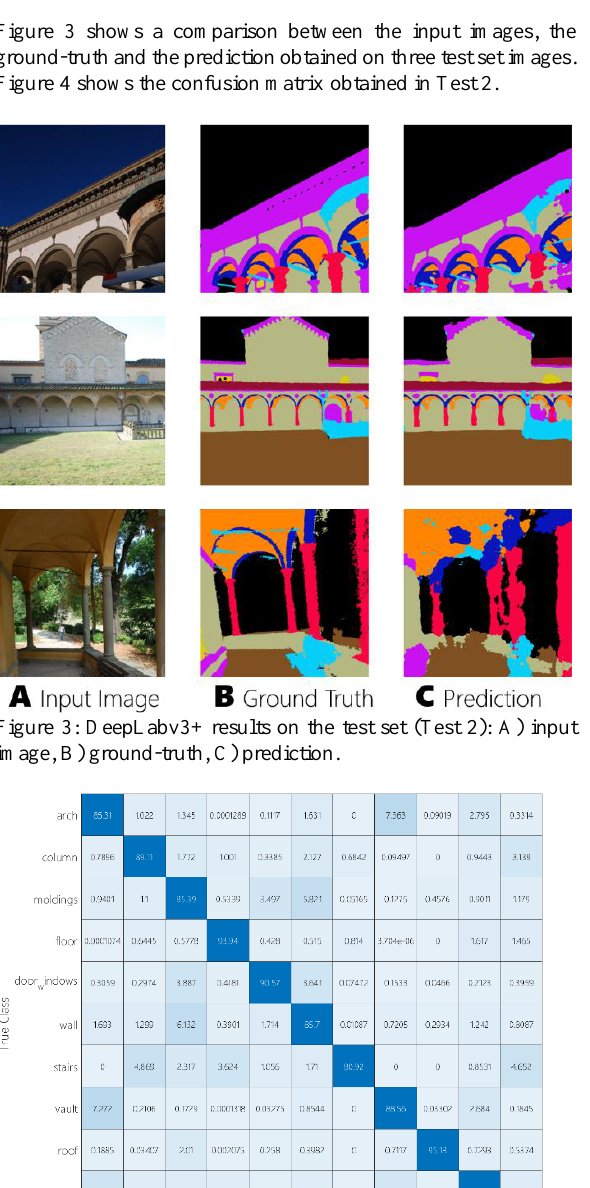
Table 4: DeepLabv3+ results on the test set (Test 2).